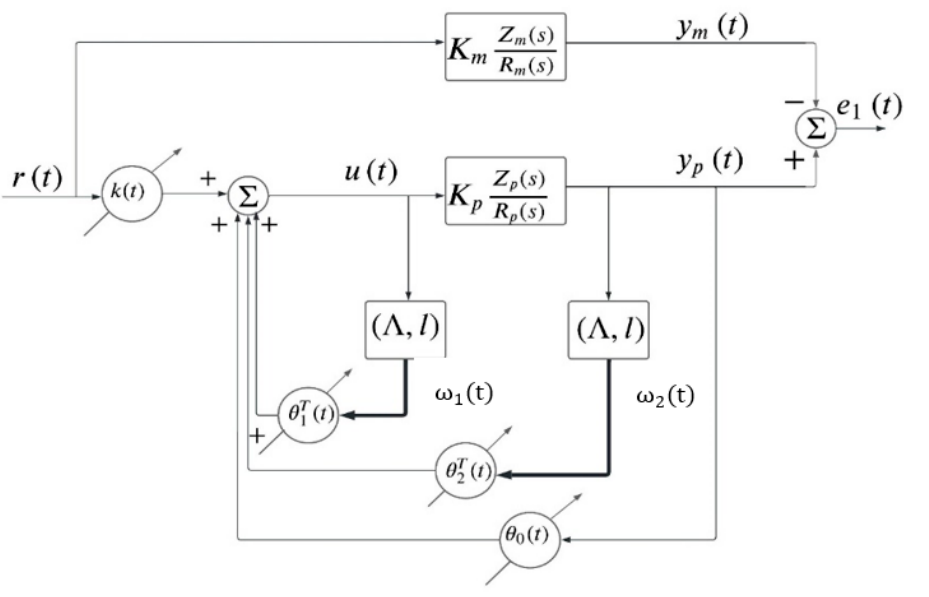
Figure 5. Structure of the DMRAC when the relative degree of the plant is 𝑛 ∗ = 1